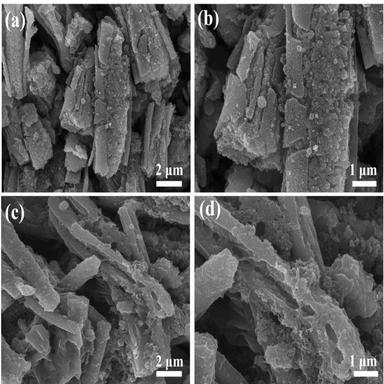
SEM images of (a,b) the Co9S8/ZnS@C and (c,d) the Co9S8/ZnS after 200 cycles.